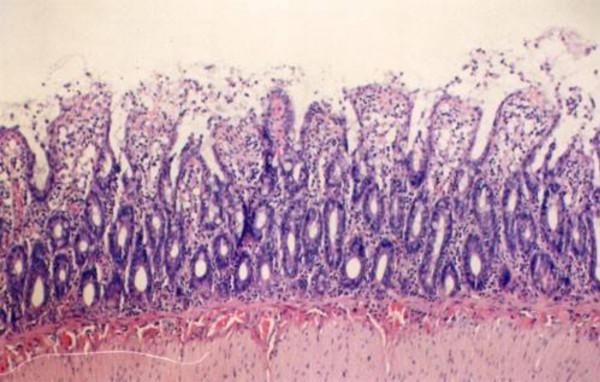
Intestinal villus after I/R in group II rats. Note lifted epithelium, white blood cells, and monocytes in the Lamina propria (Grade IV) (HE, ×100).